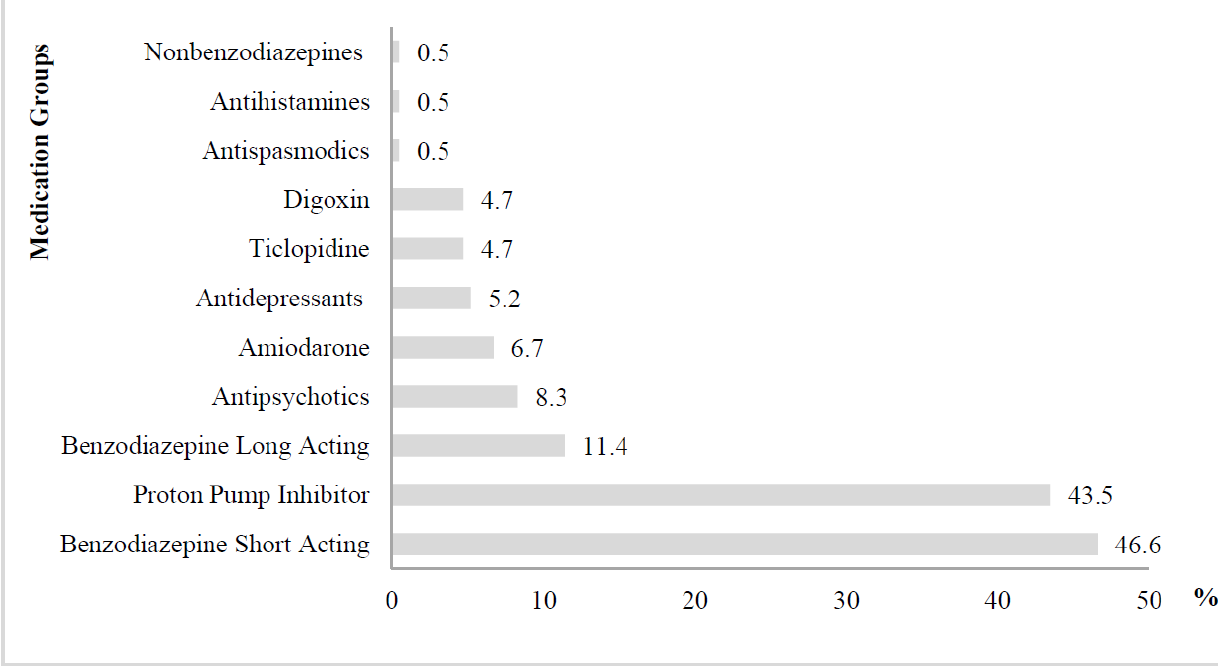
Figure 3. Therapeutic classes and drugs to be avoided for most older adults according to the Beers Criteria (independent of diagnoses or conditions).